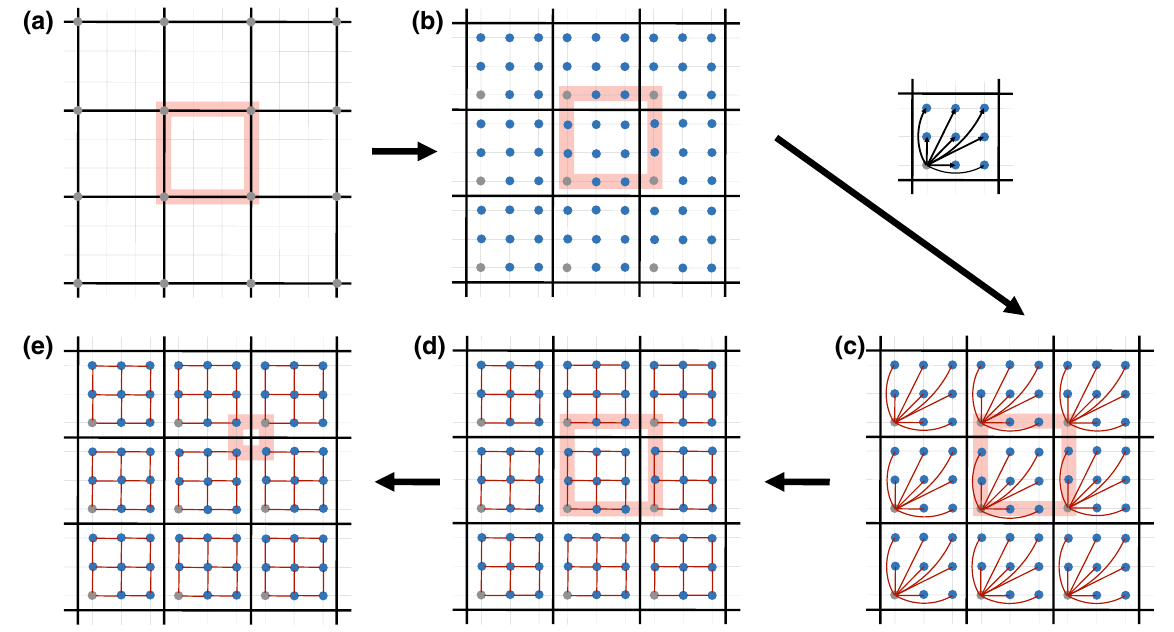
FIG. 2. Illustration of our defect network construction applied to the 2D plaquette Ising model. (a) Qubits (gray circles) governed by plaquette Ising model constraint terms (transparent orange) are shown on the original coarser lattice (black lines). A finer lattice (gray lines) is introduced for reference. The plaquettes, edges, and vertices of the original lattice define 2, 1, and 0 strata for the defect network construction. (b) The finer lattice is shifted by half a lattice spacing in all directions. Decoupled qubits (blue circles) governed by trivial single-site constraints are introduced onto the vertices of the refined lattice. ( b → c ) CNOT gates (black arrows) are applied from the original (gray) qubit in each 2 strata to the newly introduced (blue) qubits in the same 2 strata. (c) The original (gray) qubit in each 2 strata is now coupled to all newly introduced (blue) qubits in the same 2 strata via two-body ZZ Ising constraint terms (red lines). (d) We choose a new, redundant, generating set of two-body Ising constraints (red). These constraints simply correspond to blocks of the Ising model within 2 strata, and are ultralocal. The introduction of additional redundancy to the generating set of constraints requires the addition of further relations on the constraints. An ultralocal generating set of these relations is given by products of constraints around plaquettes that are fully contained within 2 strata (i.e., bounded by red edges). Up to, and including, this step the plaquette Ising model couplings (transparent orange) on the original (gray) qubits remained unchanged. They couple qubits on the scale of the coarser lattice and hence are not yet ultralocal. (e) We make use of the two-body Ising terms within the 2 strata to choose a new ultralocal generating set of plaquette Ising terms (transparent orange) located at 0 strata. In this example there are no Ising terms associated to 1 strata, and no further relations. In the general construction of a defect network for an ungauged topological CSS stabilizer models (that has been sufficiently coarse grained), an ultralocal generating set of relations involving the generalized Ising couplings is chosen at this stage, see Sec.